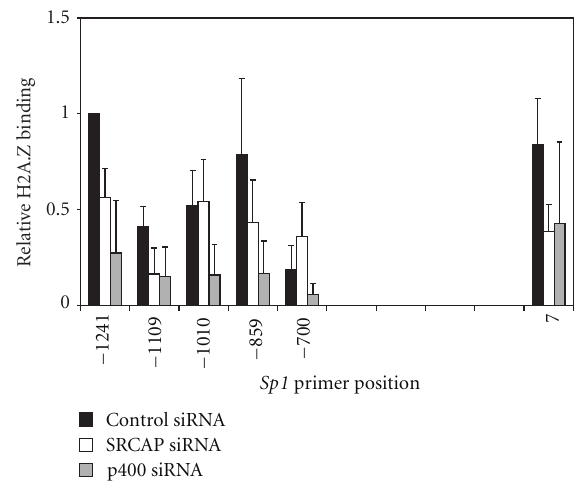
Figure 5: SRCAP and p400 regulate H2A.Z deposition equivalently at Sp1 promoter nucleosomes. 549 cells were transfected with control, SRCAP, or p400 siRNA and harvested 72 hours later. Mononucleosome ChIP assays were performed using anti-H2A.Z antibody and immunoprecipitated DNA was amplified by qPCR using the indicated primer sets (see Table S2). The amount of DNA amplified at each position is presented relative to the amount of DNA amplified at position − 1241. The graph represents the mean result and standard error of three or more independent ChIP experiments.